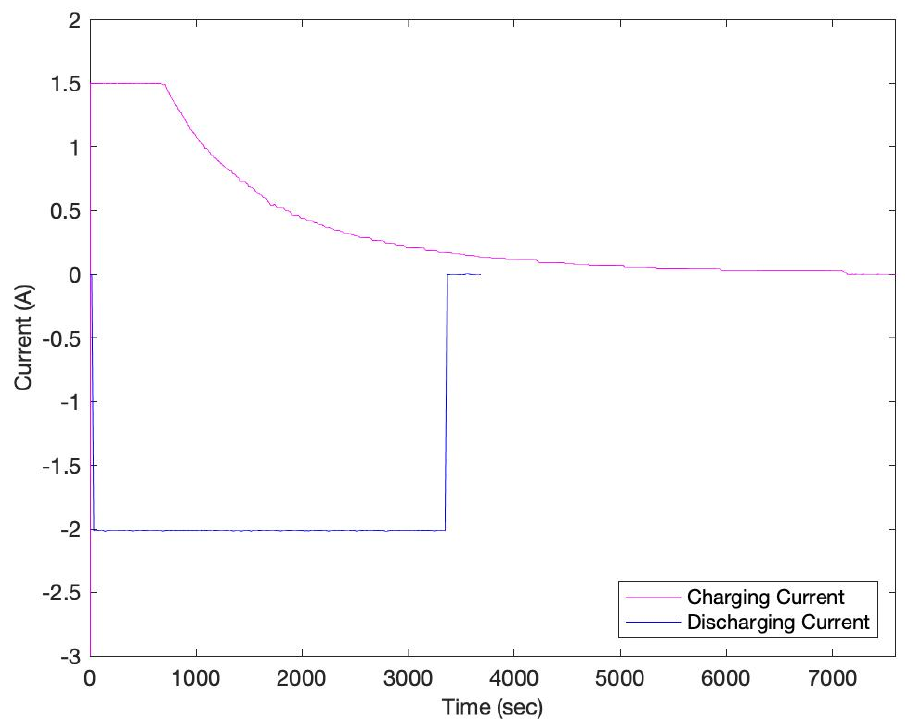
Batteries 2022 , 8 , x FOR PEER REVIEW Figure 4. The experimental charging/discharging profiles of the B0005 battery dataset over time.